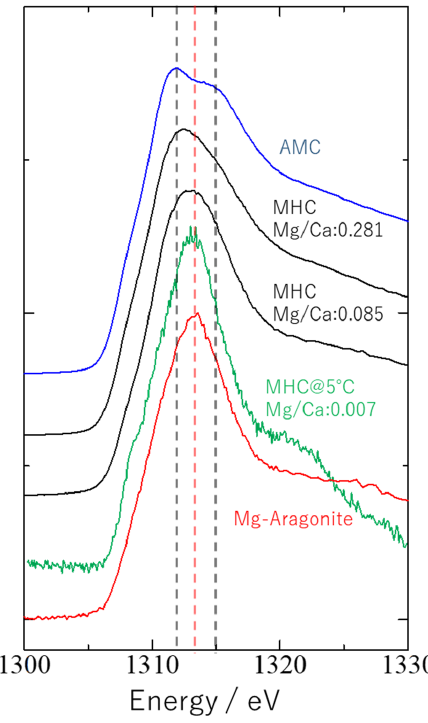
Figure 2. Mg K-edge X-ray absorption near-edge structure spectra of the monohydrocalcite (MHC) synthesized in the present study at 5 °C and an initial Na 2 CO 3 concentration of 0.1 mol/kg and four reference materials: amorphous Mg carbonate (AMC; Fukushi et al. [15]), MHC with high or low Mg content synthesized at 25 °C (Fukushi et al., [15]), and Mg-doped aragonite [15]. The spectrum for AMC showed two peaks, at 1312 and 1315 eV (black dotted lines), and that for aragonite showed a sharp peak at around 1313 eV (red dotted line).